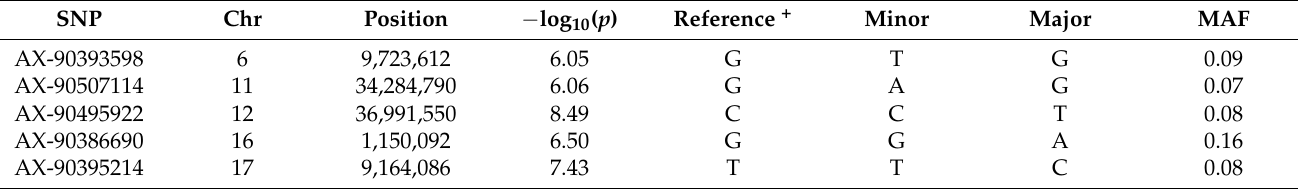
Table 2. Significant SNP markers related to DtF in the merged phenotype.